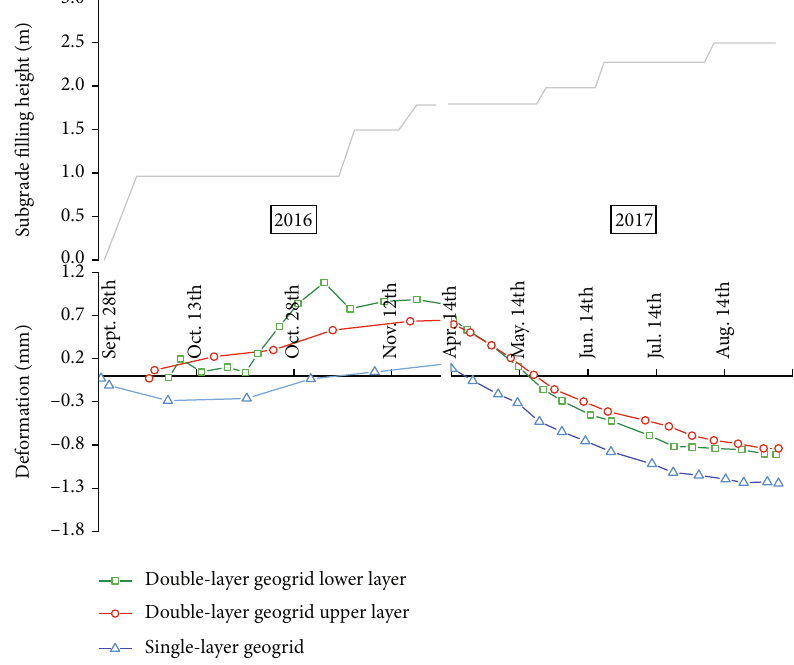
Figure 10: Deformation-time variation curve of the geogrid along the subgrade transverse direction.